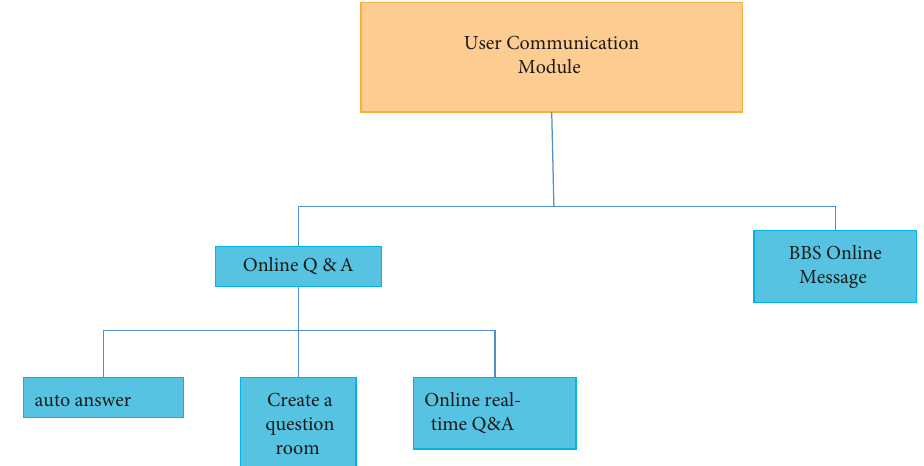
Figure 6: Schematic diagram of user communication module.